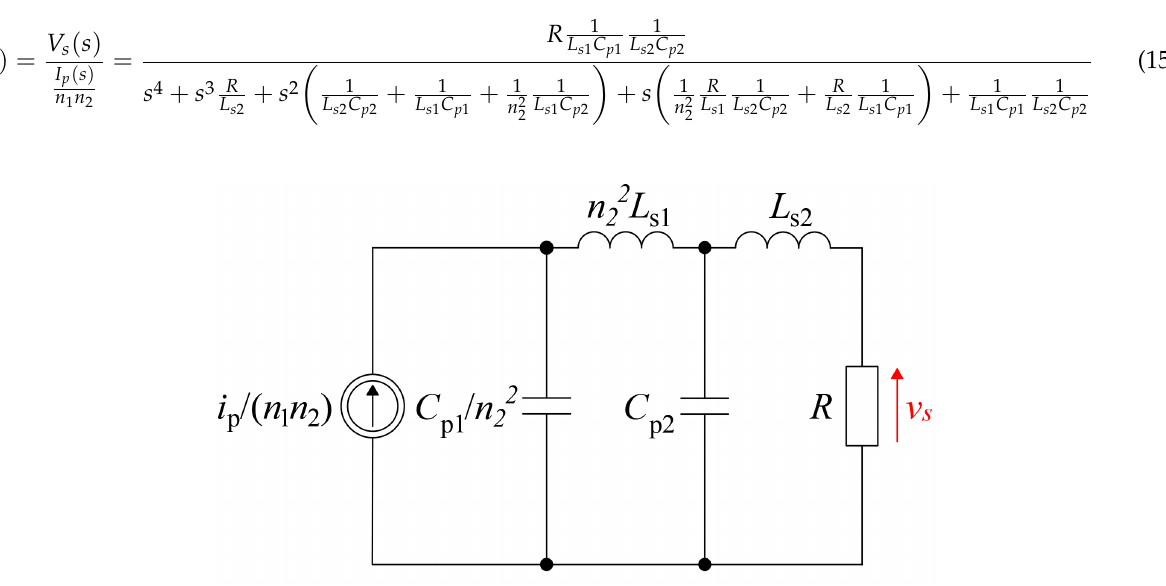
Figure 6. Proposed models of high frequency cascaded connection of HFCTs.